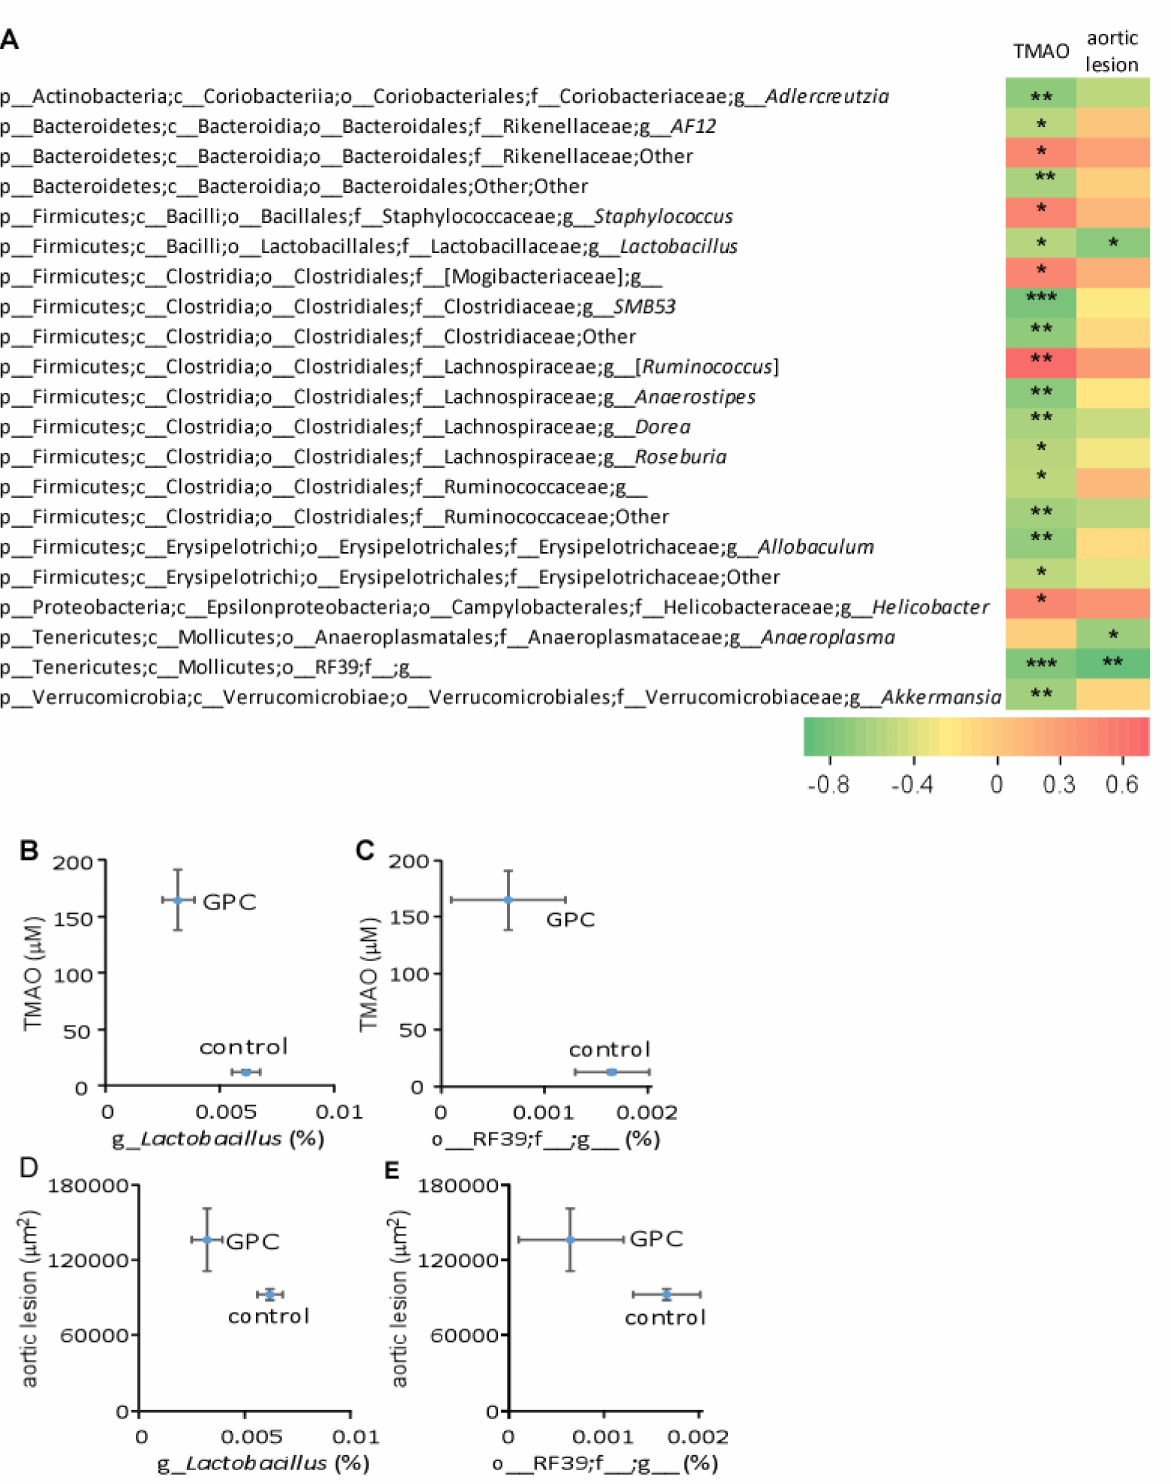
Figure 9. Bacterial taxa in mouse cecum that significantly correlate to either plasma TMAO level or aortic lesion area. ( A ) Spearman correlation heat map demonstrating the association between the indicated microbial taxonomic genera and TMAO concentrations or aortic lesion area. * p < 0.05; ** p < 0.01; *** p < 0.001. ( B – E ) GPC supplementation shifts the relative abundance of two genera that significantly correlate with plasma TMAO level or aortic lesion area. Ten female C57BL/6J Apoe − / − mice fed control chow diet and 11 female C57BL/6J Apoe − / − mice fed GPC supplemented chow diet were